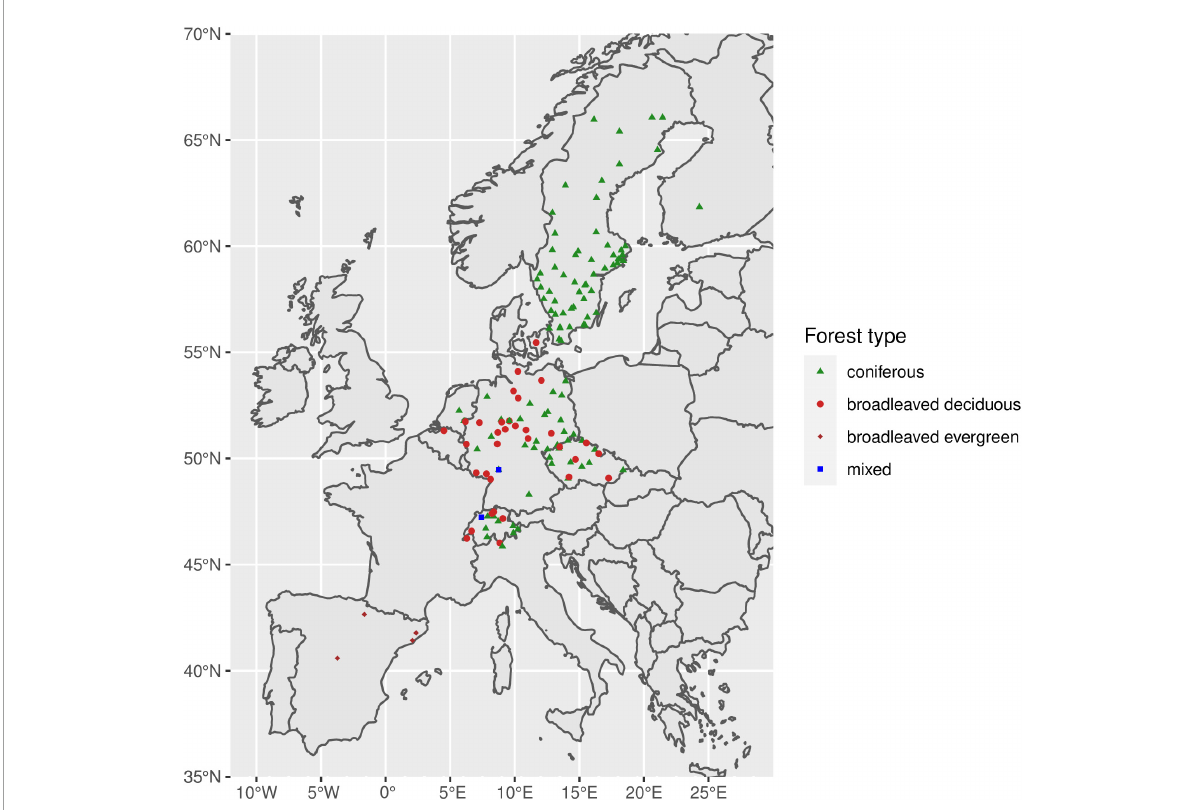
FIGURE1 Location of the plots included in the current study. Broadleaf deciduous, broadleaf evergreen, and mixed were combined to one forest group in the analysis.